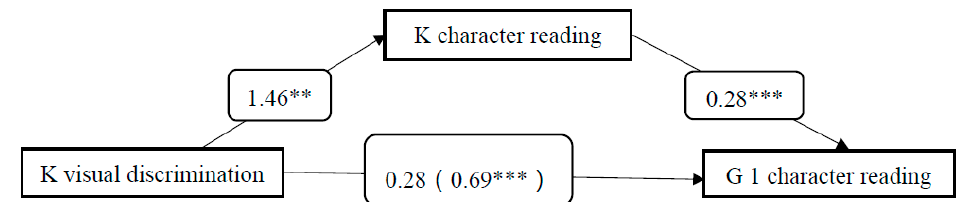
Figure 1 . Mediation model of kindergarten visual discrimination, kindergarten character reading, and Grade 1 character reading. Note. The total effect © is between brackets, outside the brackets are the direct effects (c’). K represents kindergarten and G 1 represents Grade 1. ** p < 0.01, *** p < 0.001.